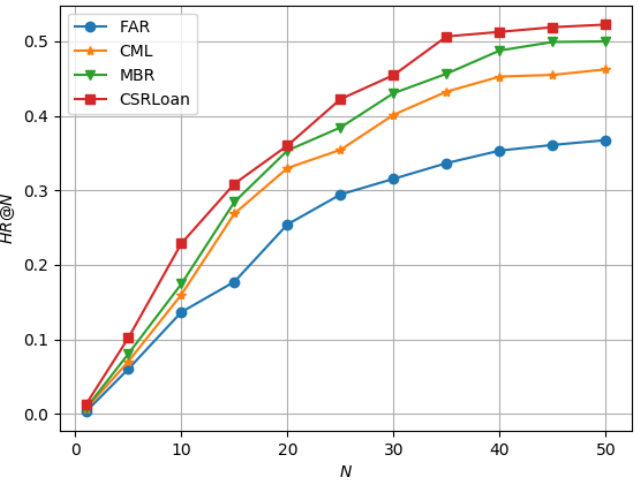
Figure 3. HR@N of loan recommendation where N ranges from {1, 5, 10, 15, ..., 45, 50}.